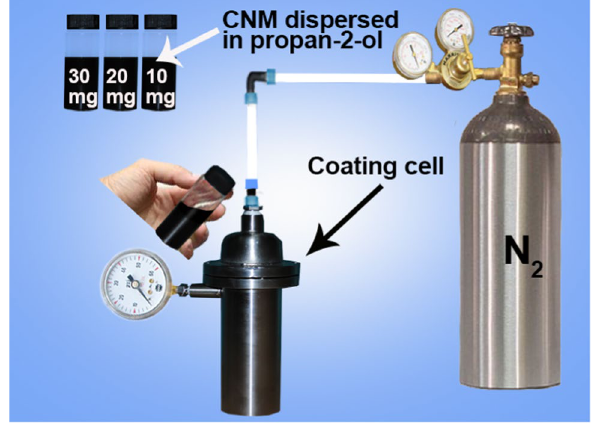
Fig. 1 Coating cell using the liquid entry pressure